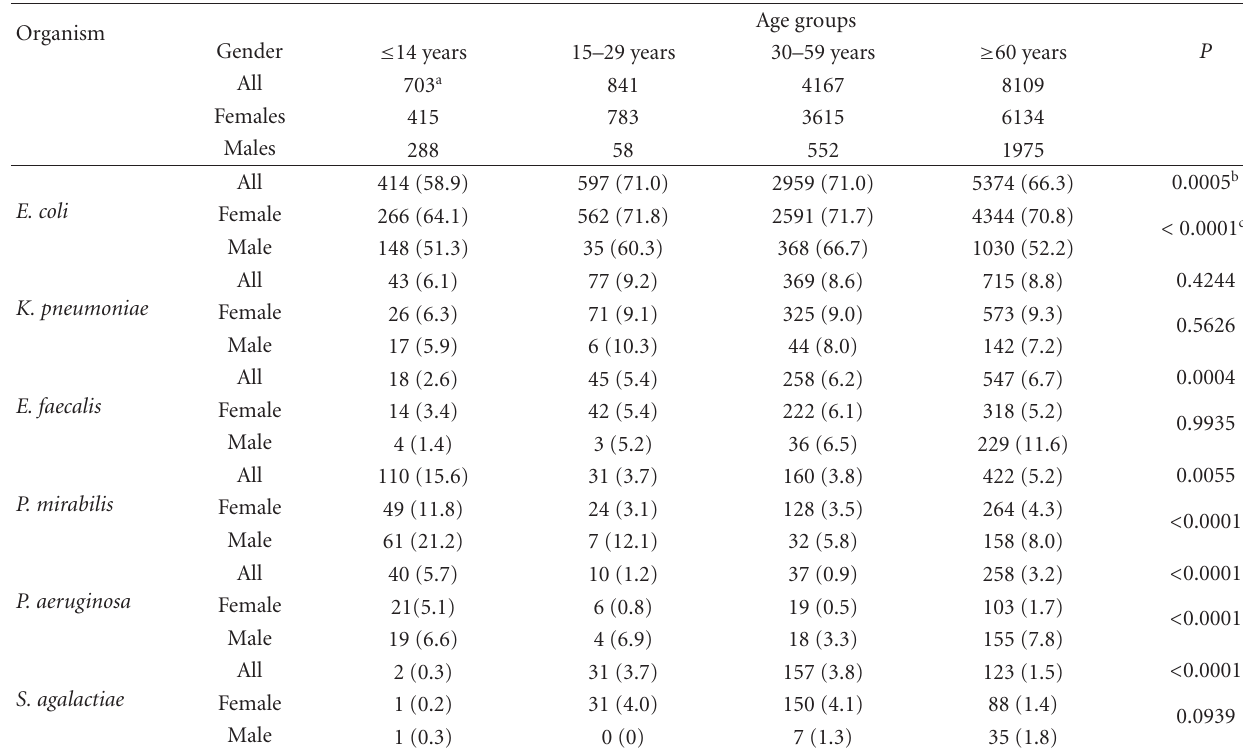
Table 3: Distribution of urine pathogens according to age groups and gender. Data are reported as number of isolates and percentages (within brackets) of total patients in each age group.